Question: Provide a one-line summary of what is displayed.
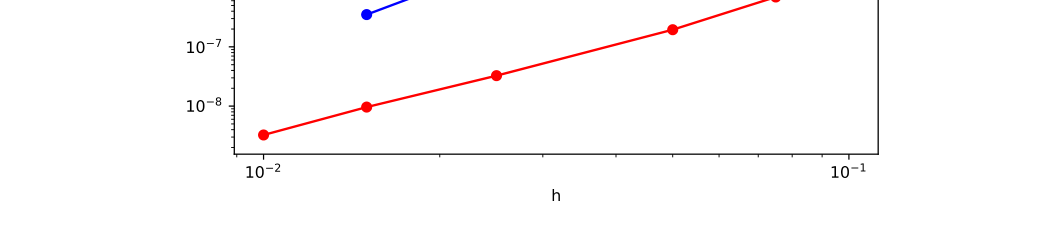
Answer: 7: In case of this linear patch test, we can observe linear convergence regarding the residual error for the multiplicative Schwarz approach.